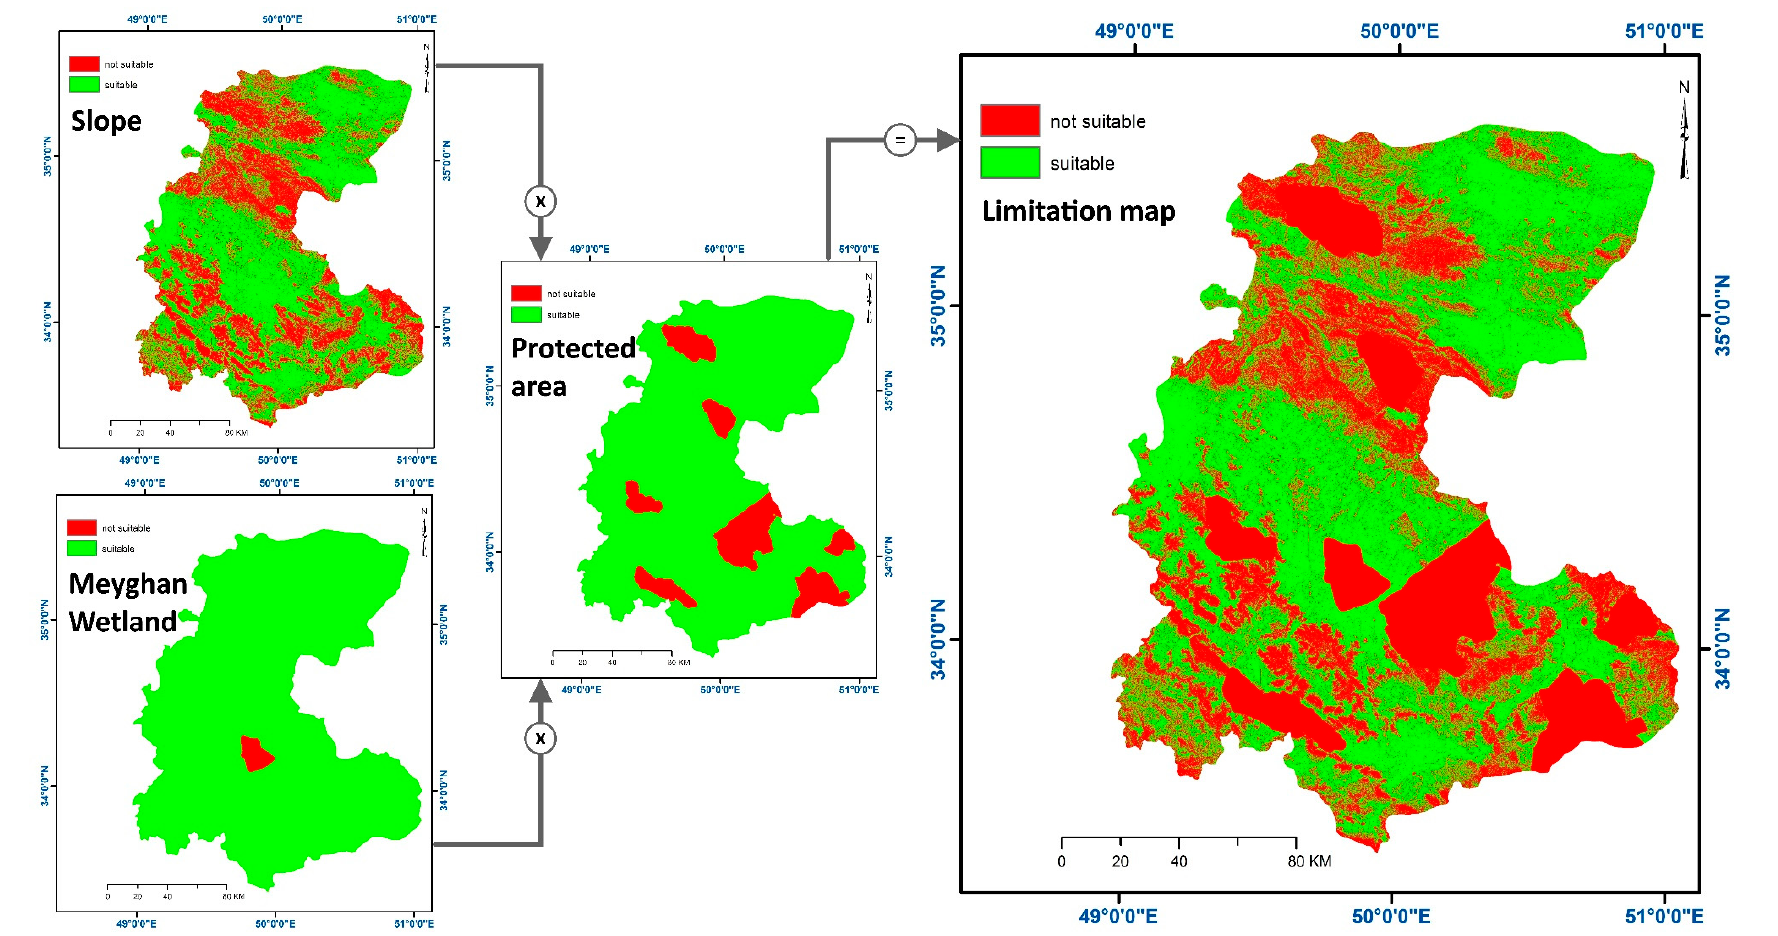
Figure 6. Restriction maps used to determine aquaculture land use in Markazi province: slope (%), protected area, Meyghan Wetland buffer zone, and combined limitation map.